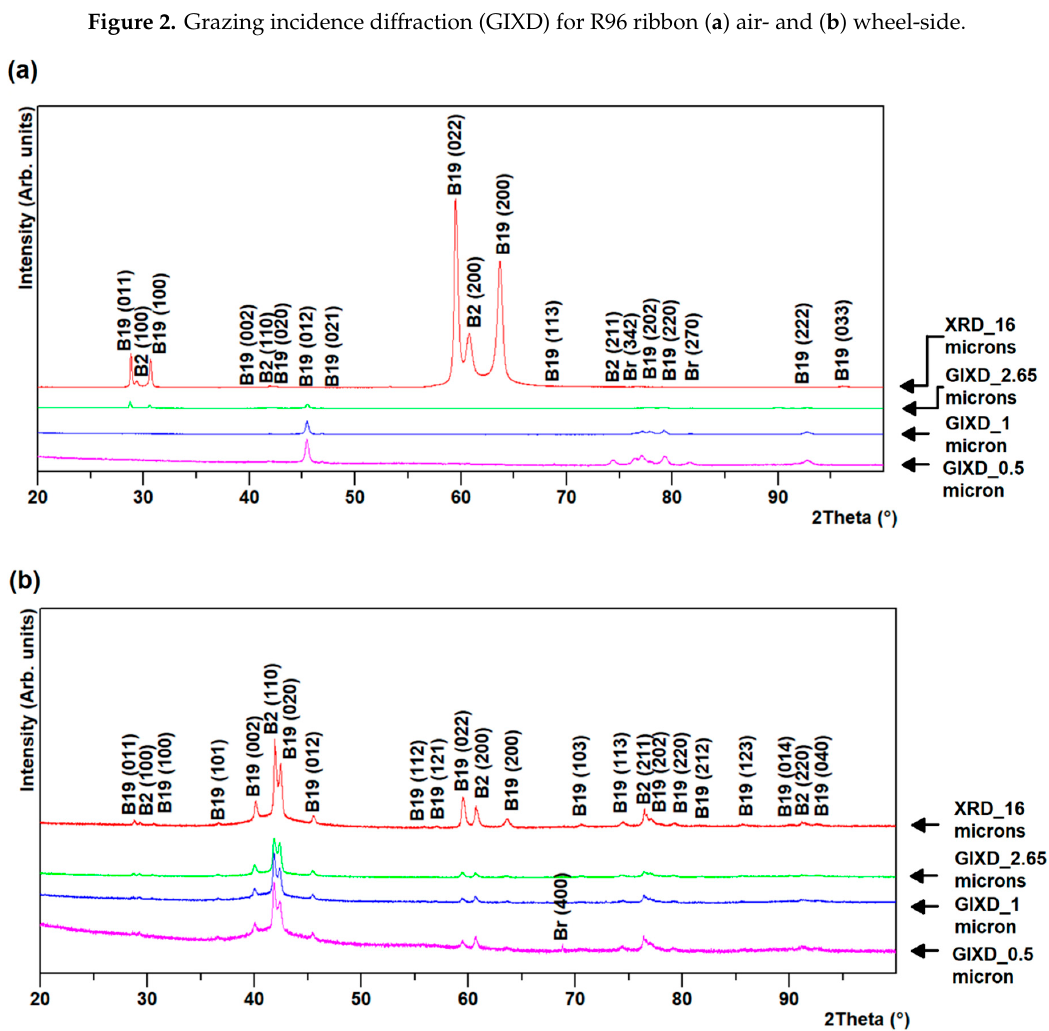
Figure 3. GIXD for R60 ribbon ( a ) air- and ( b ) wheel-side.